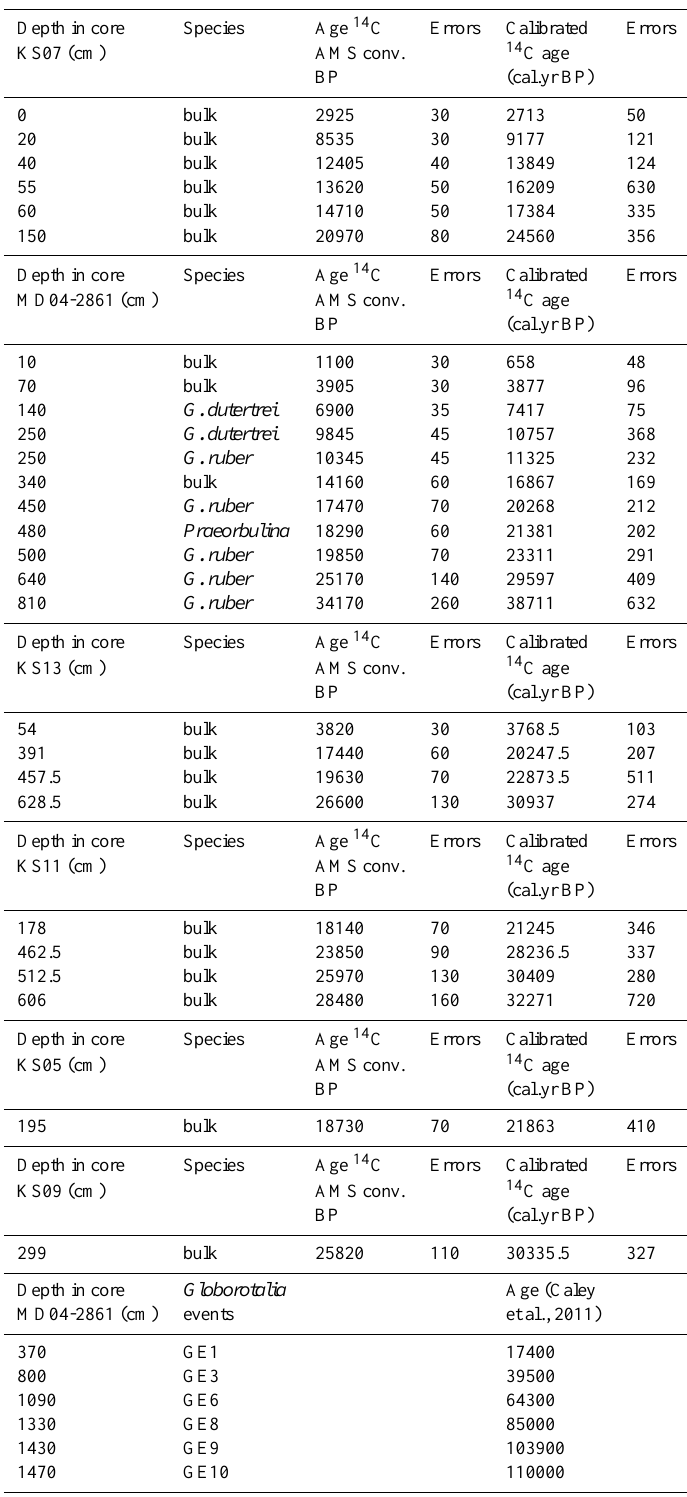
Table 1. 14 C dating in cores KS07, KS13, KS11, KS05, KS09, and MD04-2861 (Caley et al., 2011a) and age constraints of GEs in core MD04-2861 (Caley et al.,